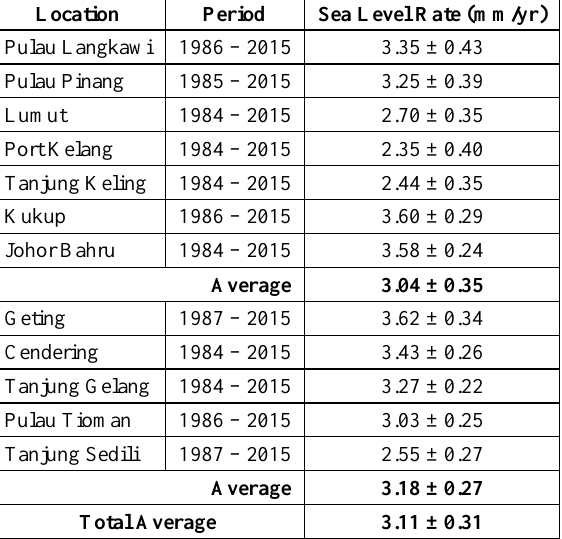
Table 2. Sea Level Rate (mm/yr) using Robust Fit Regression Analysis for All Peninsular Malaysia Tide Gauge Stations